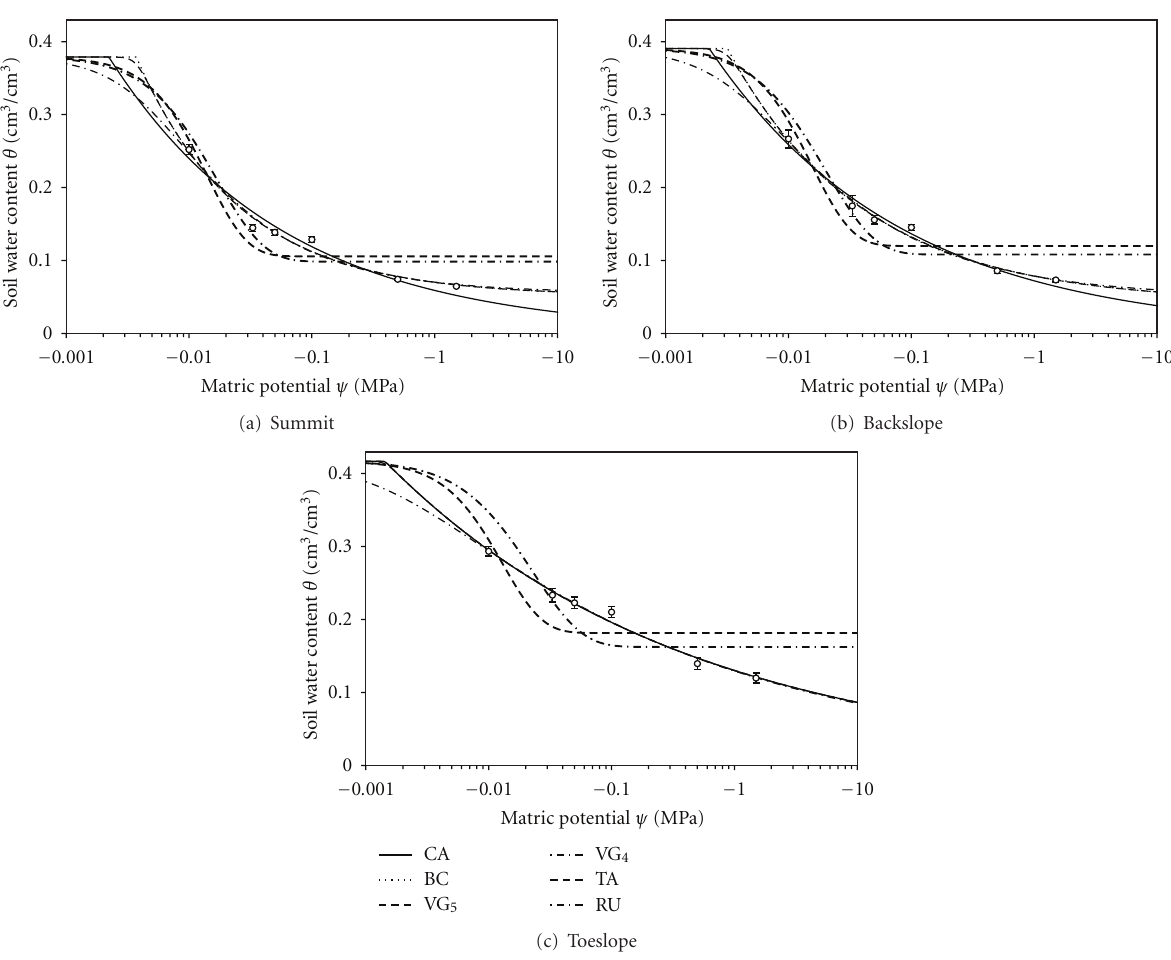
Figure 3: Fitted SWRC for soil water contents ( θ ) at soil matric potentials ( ψ ) for the (a) summit, (b) backslope, and (c) toeslope positions averaged across two hillslopes using the Campbell (CA) model with absent θ r parameter, and Brooks-Corey (BC), five- and four-parameter van Genuchten (VG 5 and VG 4 ), Tani (TA), and Russo (RU) models with θ r estimated as one of the fitted parameters. Error bars are SE for six water retention